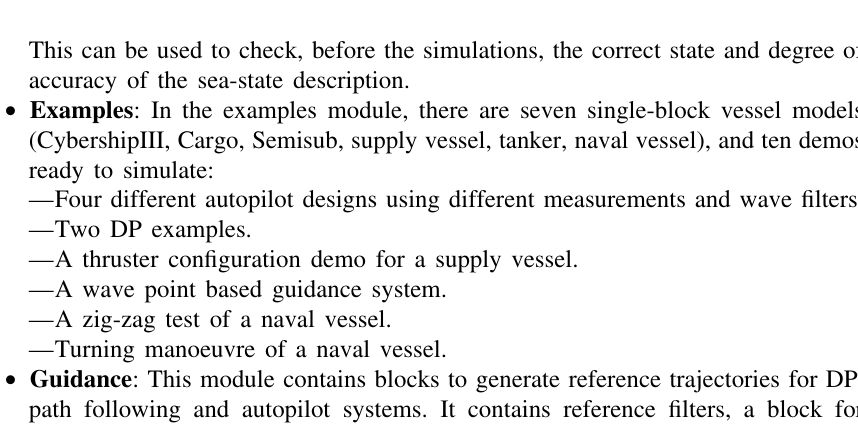
Figure 4. Simulink library browser showing the Marine GNC Toolbox after